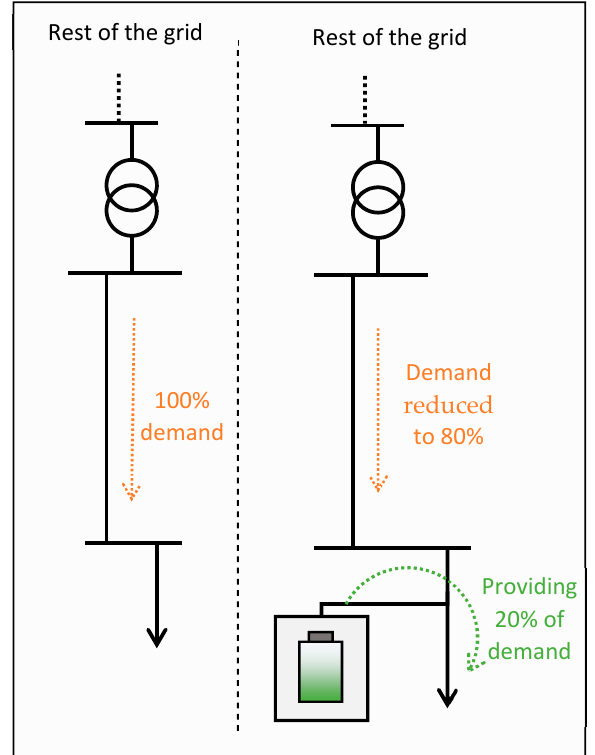
Figure 6. Illustration of Transmission & Distribution congestion relief (from Katsanevakis, Stewart and Lu [103]).